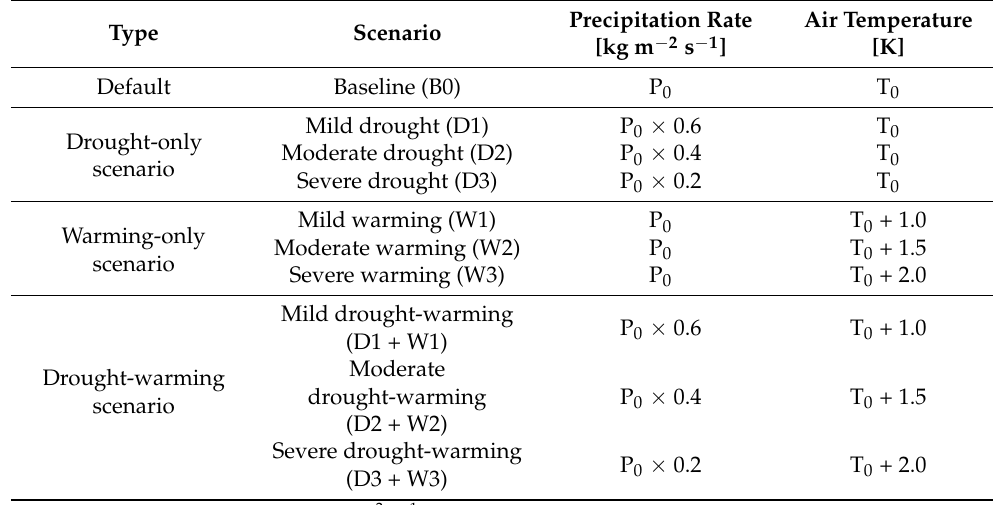
Table 4. ED-2.2 model scenario settings for baseline, drought, and/or